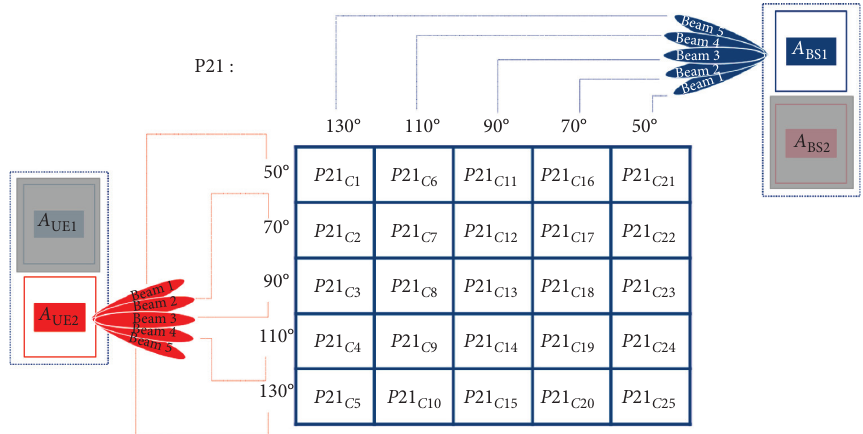
Figure 20: P21, a particular power matrix for the h